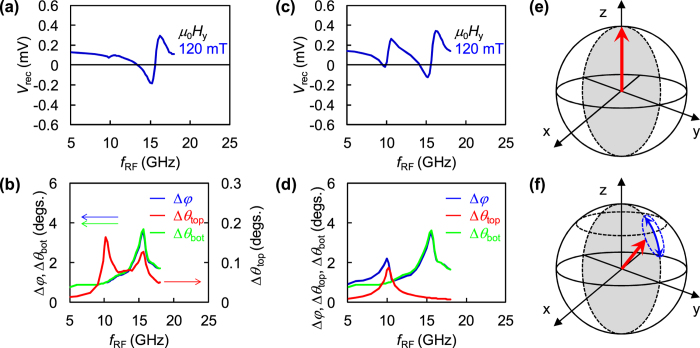
Micromagnetic simulation results and schematics of magnetization dynamics under VCMA.(a) Simulation results of Vrec as function of fRF when VCMA is applied to bottom CoFeB layer. (b) Δφ (blue line), Δθtop (red line), and Δθbot (green line) as functions of fRF when VCMA is applied to bottom CoFeB layer. (c) Simulation results of Vrec as function of fRF when VCMA is applied to both top and bottom CoFeB layers. (d) Δφ (blue line), Δθtop (red line), and Δθbot (green line) as functions of fRF when VCMA is applied to both top and bottom CoFeB layers. (e,f) Schematic figures of magnetization dynamics in bottom CoFeB layer without and with Hy, respectively.